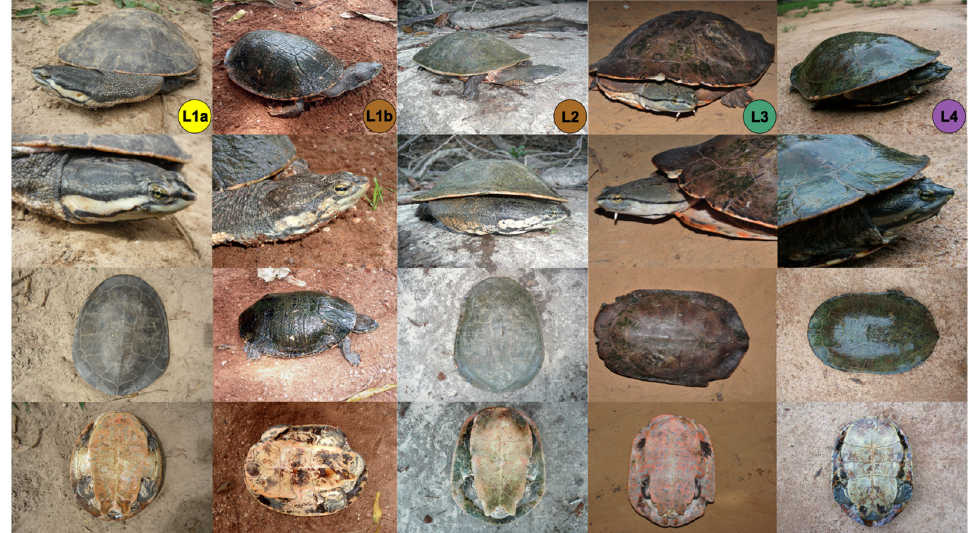
Figure 6. Morphological variation of the Phrynops geoffroanus species complex in shape and color of body and head. Lineages: lineage L1a = INPA-H 26127; lineage L1b = INPA-H 34260; lineage L2 = INPA-H 34345; lineage L3 = INPA-H 34879; lineage L4 = INPA-H 27810.